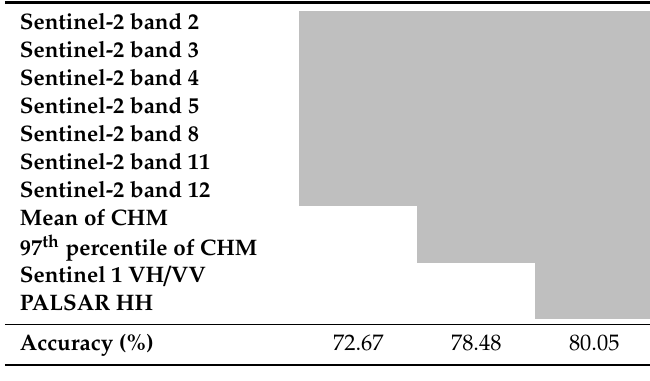
Table 3. Five-fold cross-validation accuracy of predicted forest physiognomic types from support vector machine classification from three distinct groups, the significant optical bands, the significant LiDAR metrics, and the significant radar bands. Grey shade shows which bands were used.